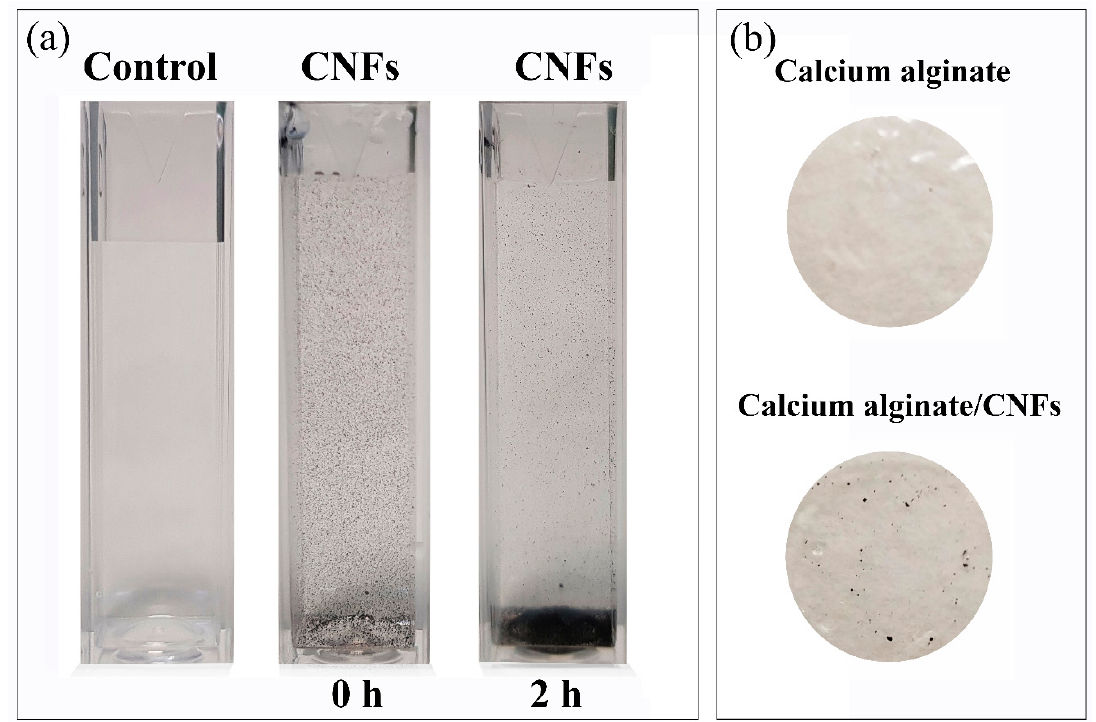
Figure 1. Dispersion of carbon nanofibers at 80 µ g/mL after sonication (0 h) and after the dispersion was idle for 2 h ( a ), and films of calcium alginate and calcium alginate/CNFs (carbon nanofibers) ( b ).